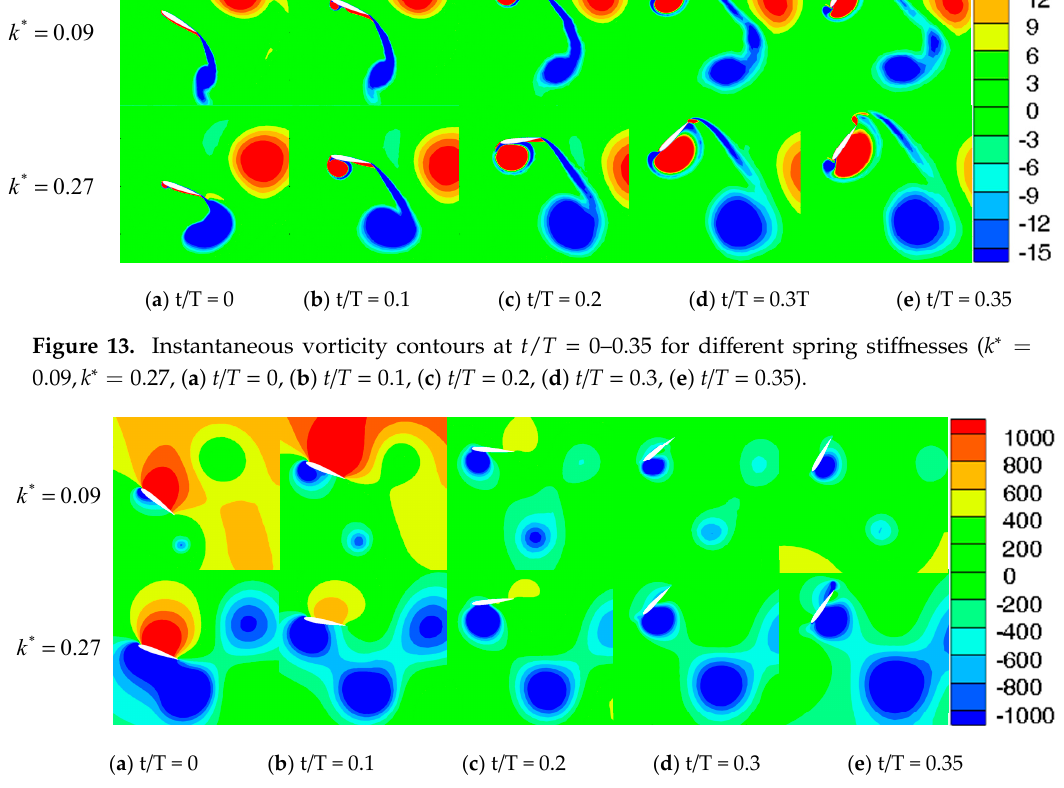
Figure 14. Instantaneous pressure contours at t/T = 0 − 0.35 for different spring stiffnesses ( 𝑘 ∗ = 0.09, 𝑘 ∗ = 0.27 , ( a ) t/T = 0, ( b ) t/T = 0.1, ( c ) t/T = 0.2, ( d ) t/T = 0.3, ( e ) t/T = 0.35).